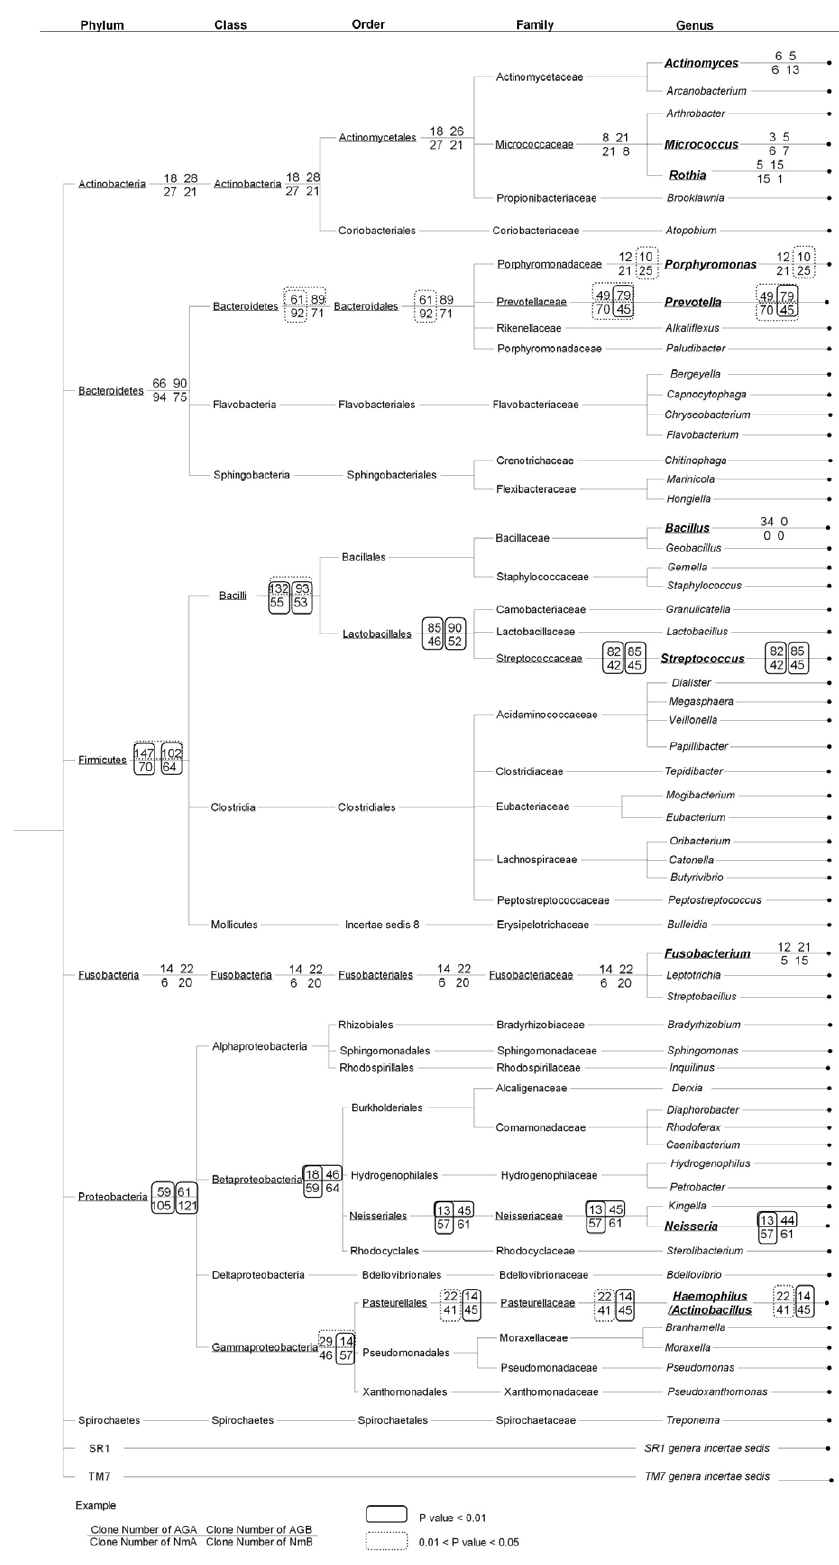
Figure 1. The taxon tree for the stomach microbiota. The tree was created based on the RDPII classifier based on a naive Bayesian rRNA classifier. The clone numbers for the top 5 phyla, top 6 classes, top 6 orders, top 7 families and top 10 genera were shown. Each taxon with at least 10 clones in all four sample groups (AGA, AGB, NmA, NmB) was analyzed by Pearson’s chi-square test by comparing the clones numbers between AGA and AGB, NmA and NmB, AGA and NmA, and AGB and NmB. The clone numbers for all phylotypes were shown in Supplementary Figure S1.